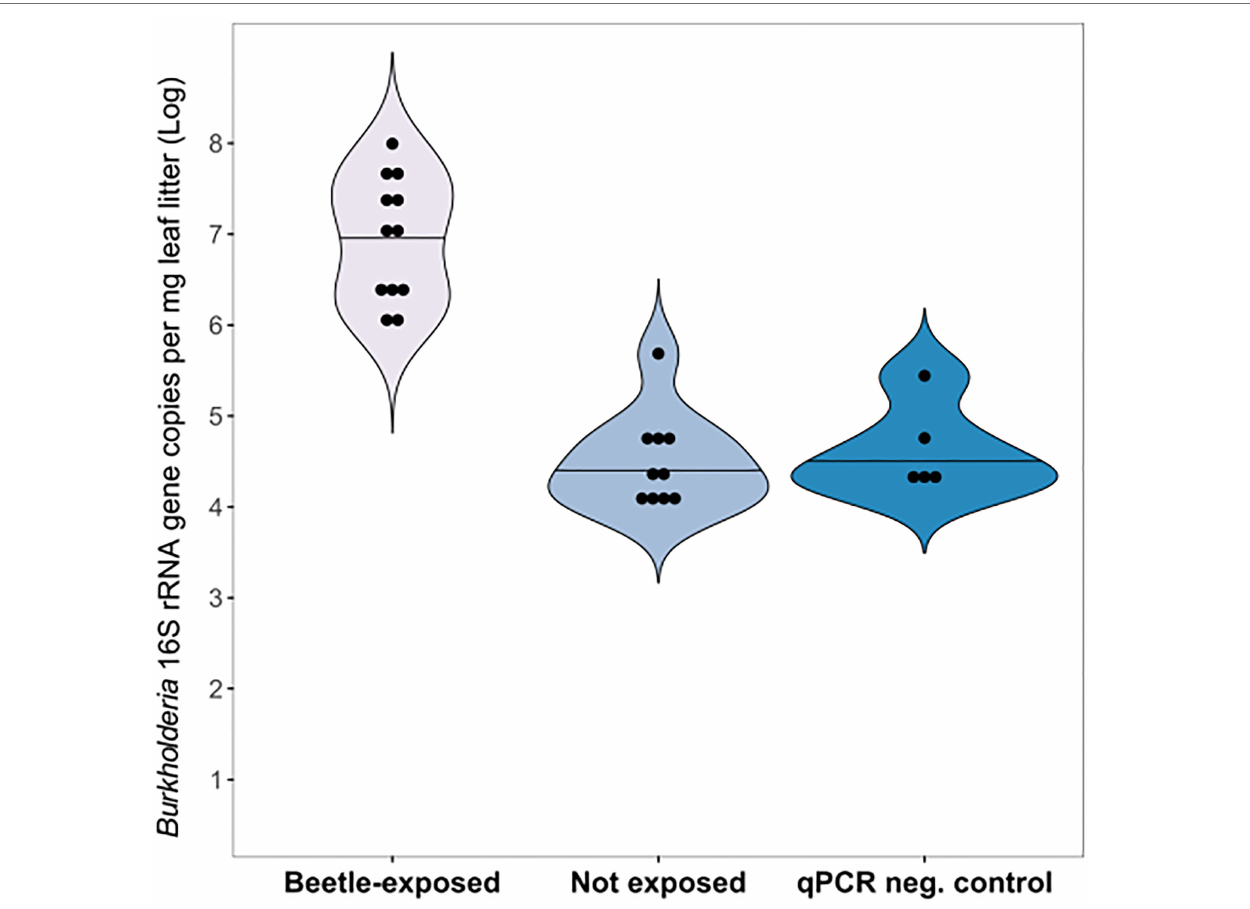
FIGURE 3 | Symbiont transmission from beetles to leaf litter. Burkholderia 16S rRNA was detected in leaf litter samples exposed to adult L. villosa beetles ( N = 12) in significantly higher copy numbers than in unexposed leaves serving as a control ( N = 10; Wilcoxon Rank Sum test, p < 0.001), which resembled quantitative PCR (qPCR) negative controls (NC). Dots within the violin plot represent individual samples and horizontal lines indicate the median. NC includes sterile water (3x) and Escherichia coli genomic DNA